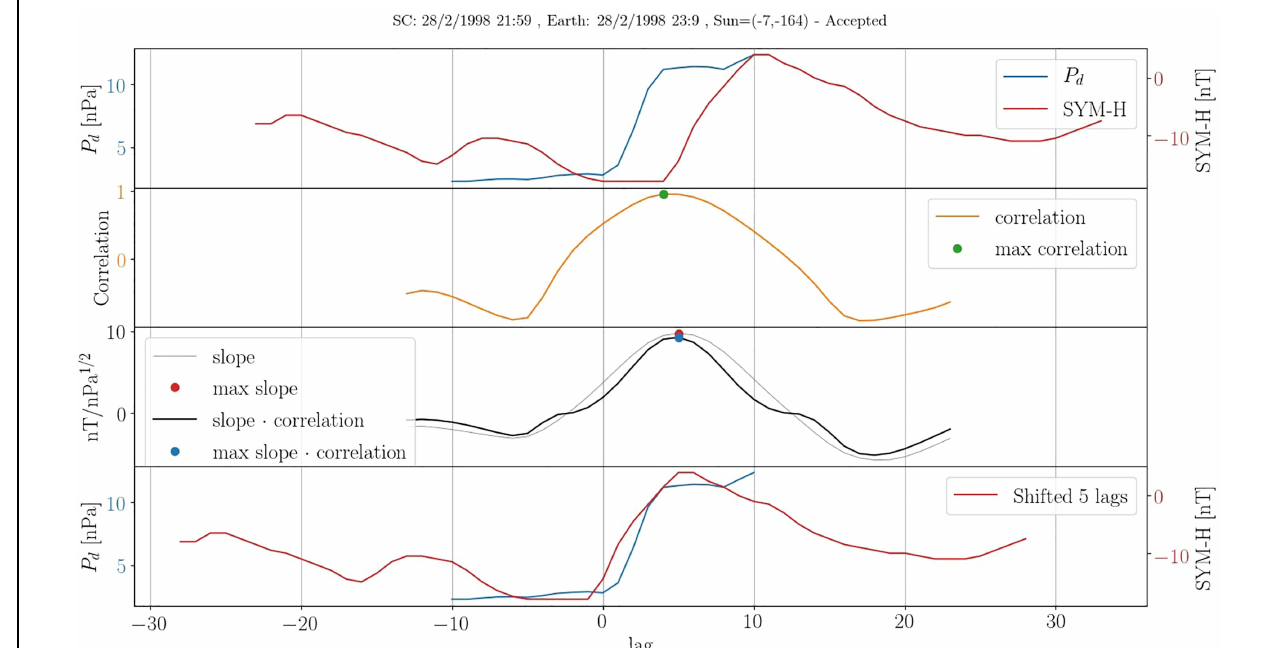
FIGURE 3 | Example of the correlation analysis on event detected by ACE at 22 UT the February 28, 1998. The first panel shows P d increase as observed by ACE along with SYM-H after around the event’s initial arrival time estimate. The second panel shows the correlation when sliding P d over SYM-H in the first panel. The third panel shows the slope from a linear fit between SYM-H and √ P d and the product of the slope and correlation. The fourth panel repeats the first panel when correcting the arrival time using the lag indicated by the blue dot in the third